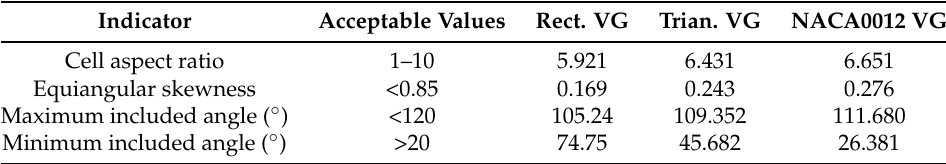
Table 2. Quality meshing parameters.